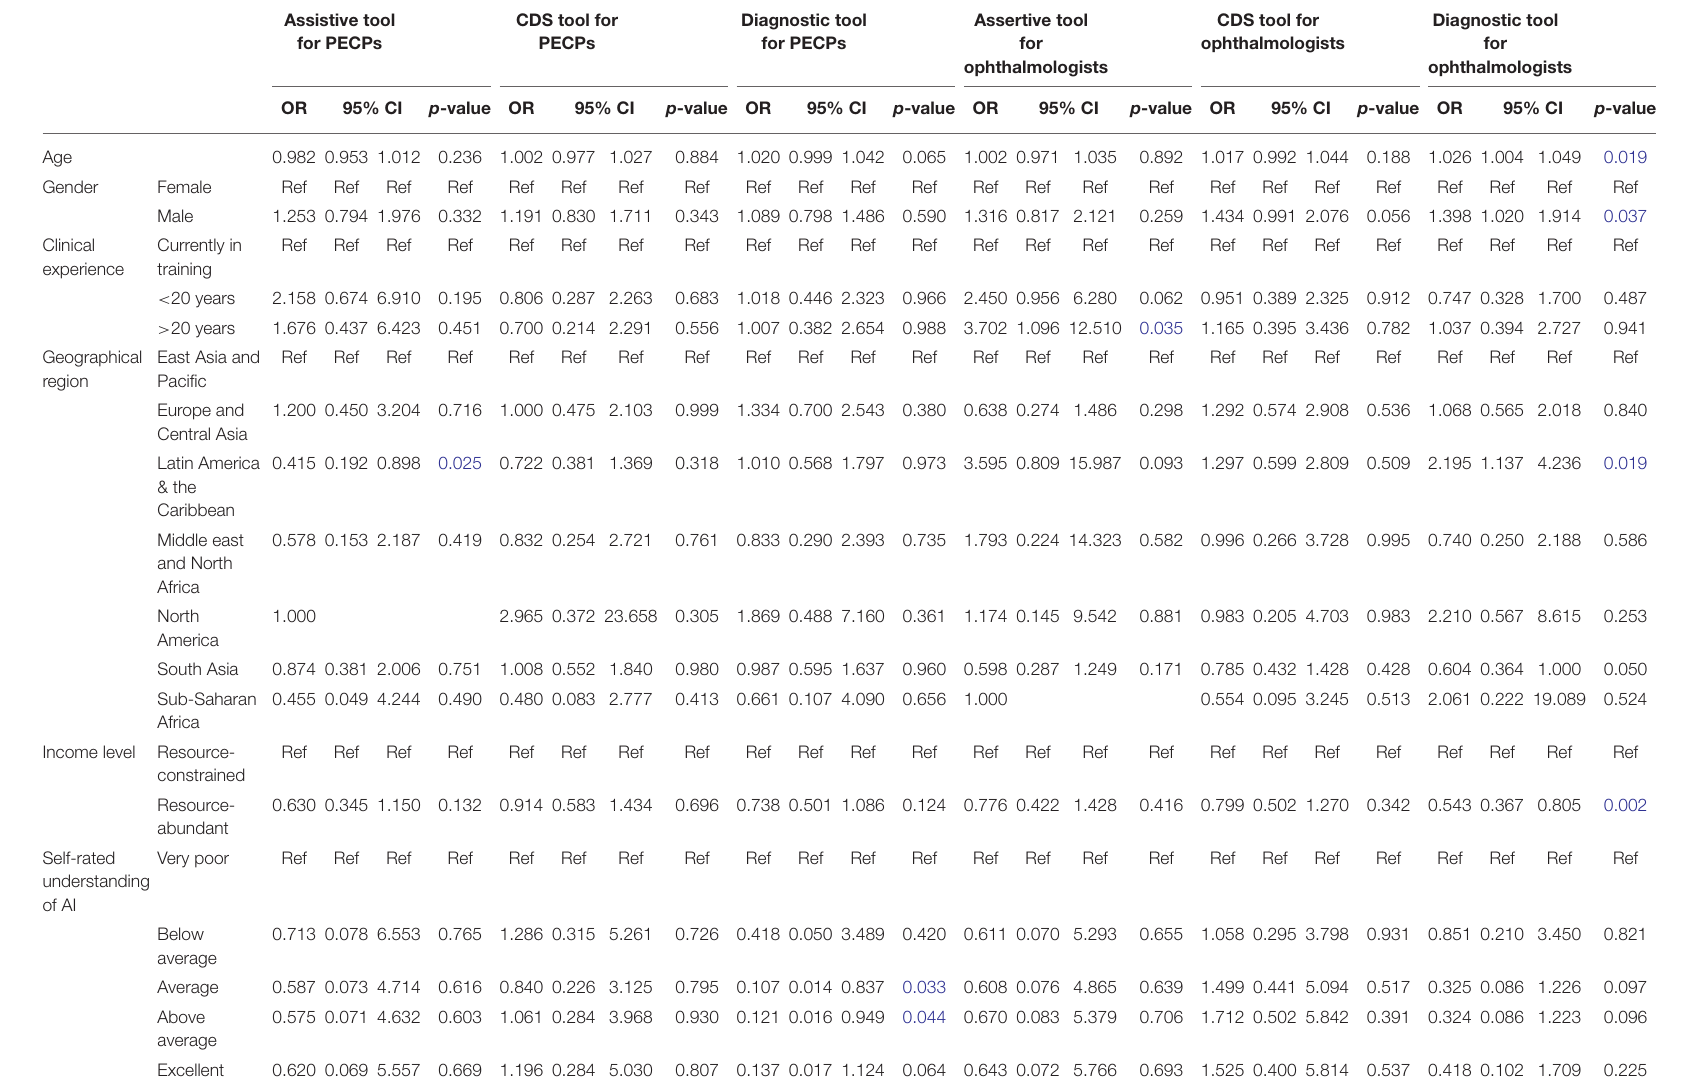
TABLE 2 | Multivariate analysis for professional acceptance of artificial intelligence (AI) applications in Ophthalmology.